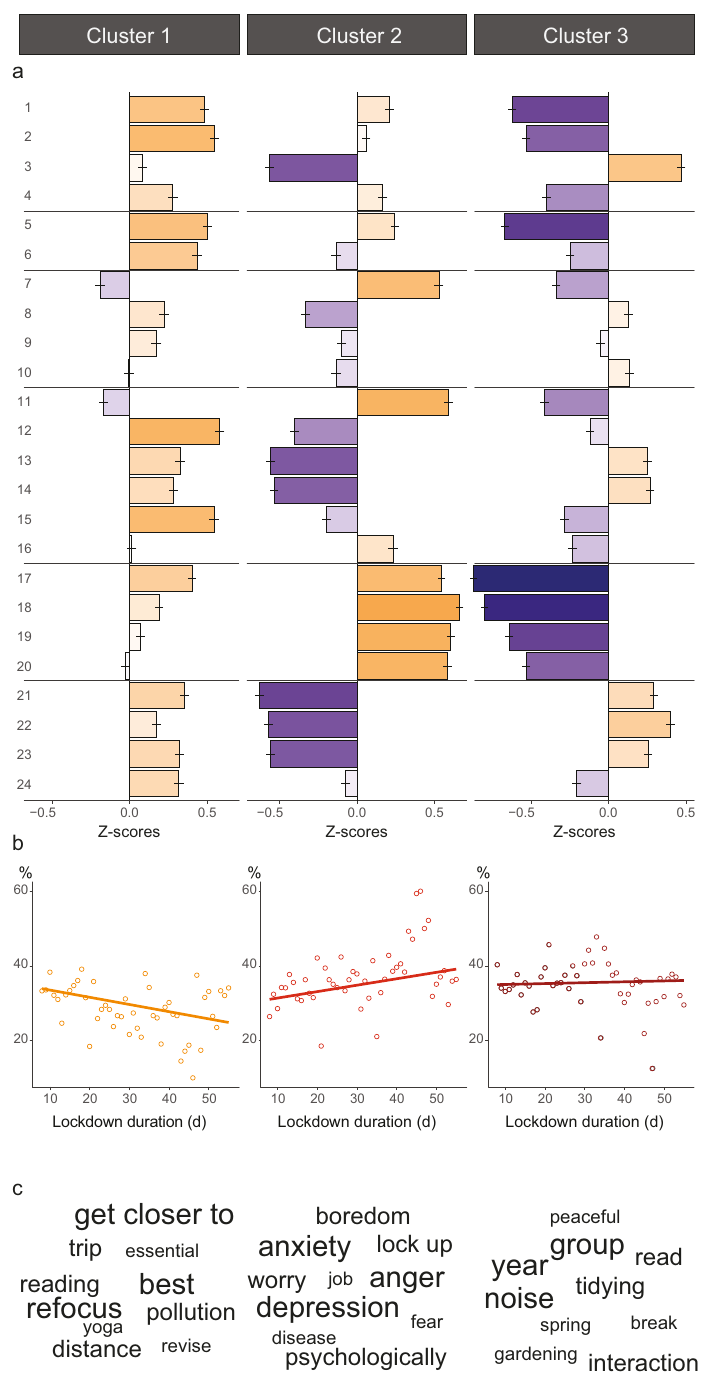
Fig. 3 Participants pro fi les during the lockdown. Part a represents the details of the three generated clusters of participants for the 16 sentences (1 – 16) and 8 feelings (17 – 24) used to perform k-means clustering (the details of sentences and feelings are available in the Table 2; errors bars correspond to the 95 con fi dence interval). Part b represents the proportion of participants corresponding to each cluster for all lockdown day and their tendency (signi fi cant only for clusters 1 and 2). Part c represents the 10 most speci fi c words used by the three